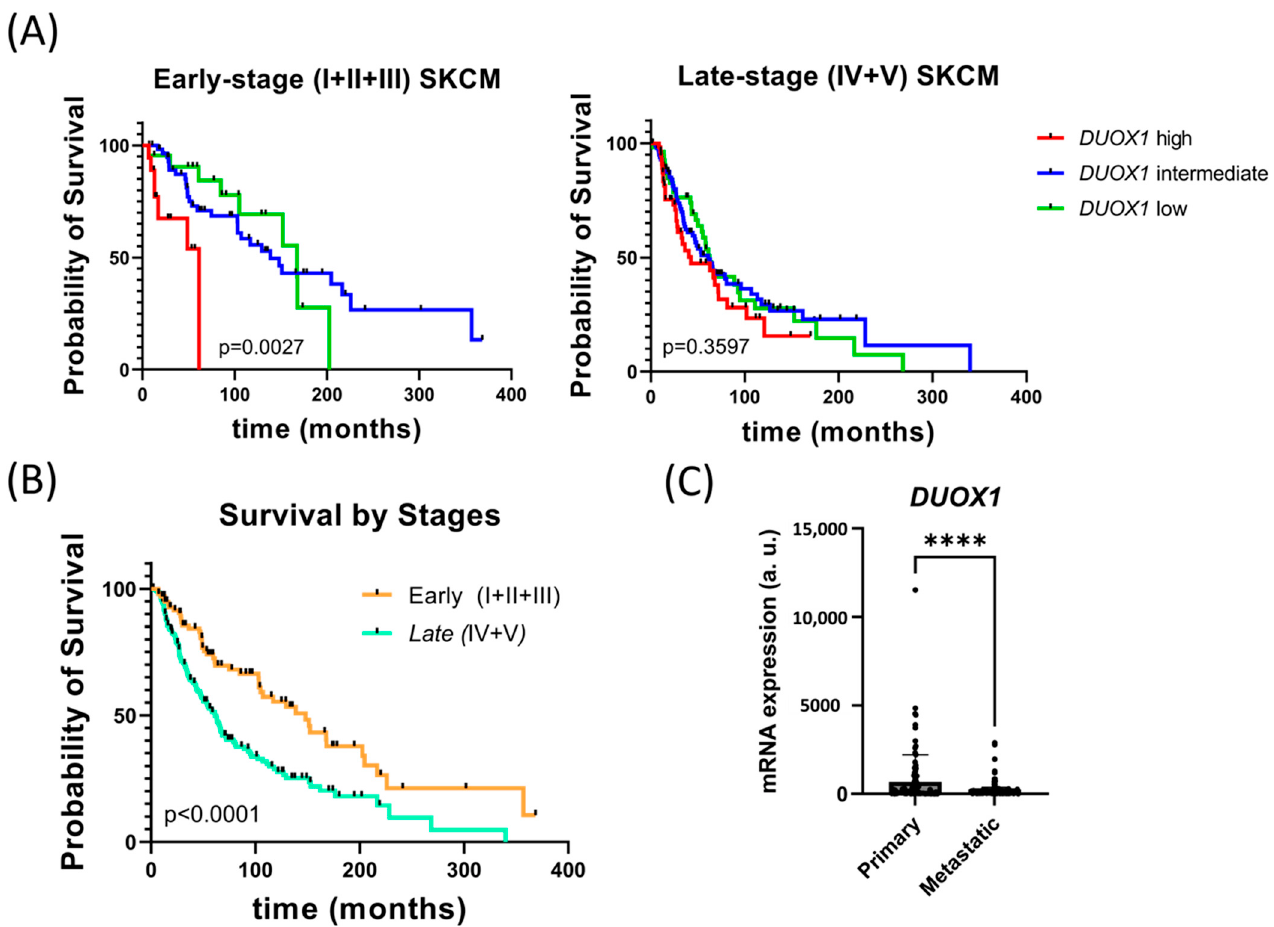
Figure 1. DUOX1 expression correlates with survival in SKCM patients and decreases in metastatic SKCM. ( A ) Kaplan–Meier survival analysis of TCGA cohort of early- (I + II + III Clark levels at diagnosis) and late- (IV and V Clark levels at diagnosis) stage SKCM patients according to their DUOX1 transcript levels: first quartile (Low), second and third (Medium) and fourth (High). Early-stage melanoma: Low, n = 22; Medium, n = 59; High, n = 16. Late-stage melanoma: Low, n = 57; Medium, n = 100; High, n = 60. Statistical significance was calculated with Mantel–Cox test. ( B ) Kaplan–Meier survival analysis of TCGA cohort of SKCM patients according to Clark-level classi- fication at diagnosis: early-stage (I + II + III, n = 99) and late-stage (IV + V, n = 217). Statistical sig- nificance was calculated with Mantel–Cox test. ( C ) DUOX1 transcript levels in primary ( n = 102) and metastatic ( n = 360) SKCMs from TCGA cohort. Each dot represents a patient, and the mean is also shown. **** p < 0.0001 according to unpaired Student t test. a.u., arbitrary units. 3.2. Melanocyte DUOX1 Inhibition Does Not Affect Melanocyte Transformation and Early SKCM Progression We used a genetic strategy based on the ability of a DN form of zebrafish DUOX1, lacking the entire flavin domain, to robustly inhibit endogenous DUOX1 [41]. MinicoopR mitfa:DN-DUOX1 and MinicoopR mitfa:NRAS-Q61R constructs were microinjected into one-cell Casper zebrafish embryos to express oncogenic NRAS and inhibit DUOX1 in mel- anocytes. As a control, eGFP was injected instead of DN-DUOX1. Fish were examined at 5 dpf to select those with more than 10 rescued melanocytes, and then fish were followed for three months, and melanomas were scored (Figure 2A). Melanomas were categorized into five groups depending on their repigmentation or appearance: I normal, II low re- pigmentation, III nevus, IV black, and V nodular tumor (Figure 2B). The first group in- cluded fish with no melanocyte rescue, the second group included fish with some isolated